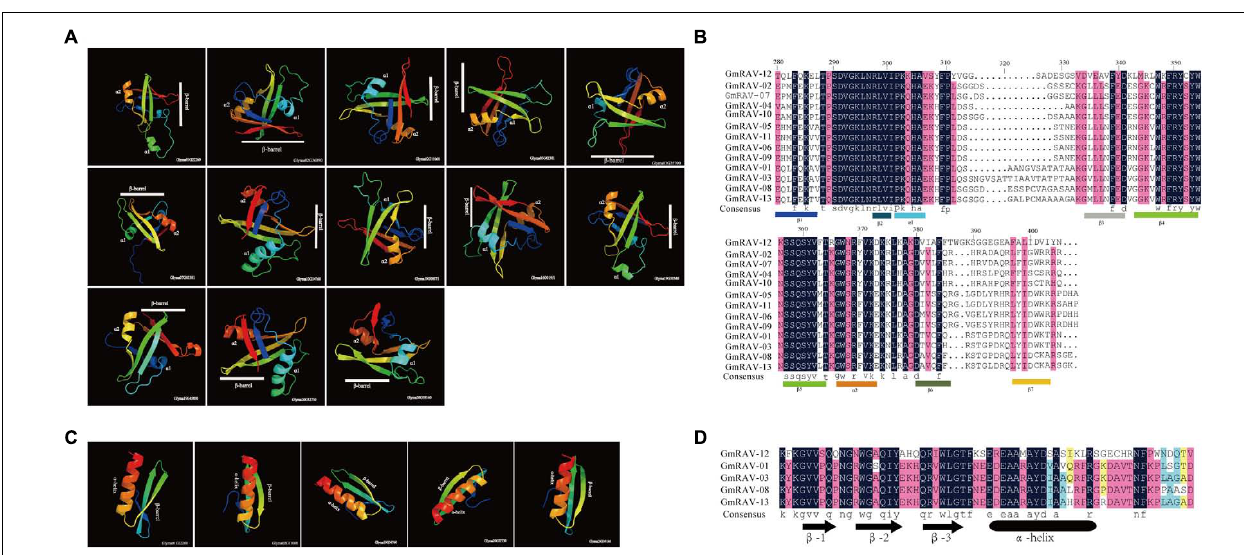
FIGURE 4 | Predicted structure of conserved domains in RAV proteins in soybean. (A) Ribbon diagrams of the B3 domains of the soybean RAV family. (B) Alignment of the B3 domains of the soybean RAV family. (C) Ribbon diagrams of the AP2 domains of soybean RAV family. (D) Alignment of the AP2 domains of the soybean RAV